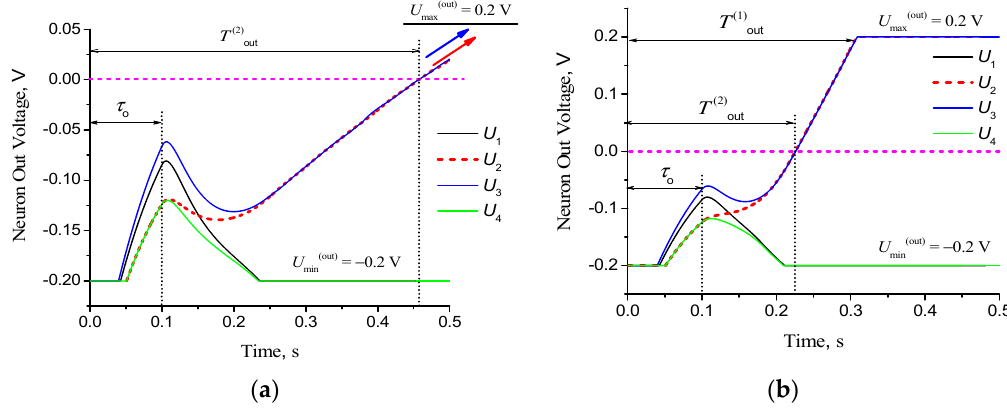
Table 3. Calculation parameters of IHN2 (Figure 9) and IHN1 (Figure 10) for the template A (Figure 8).